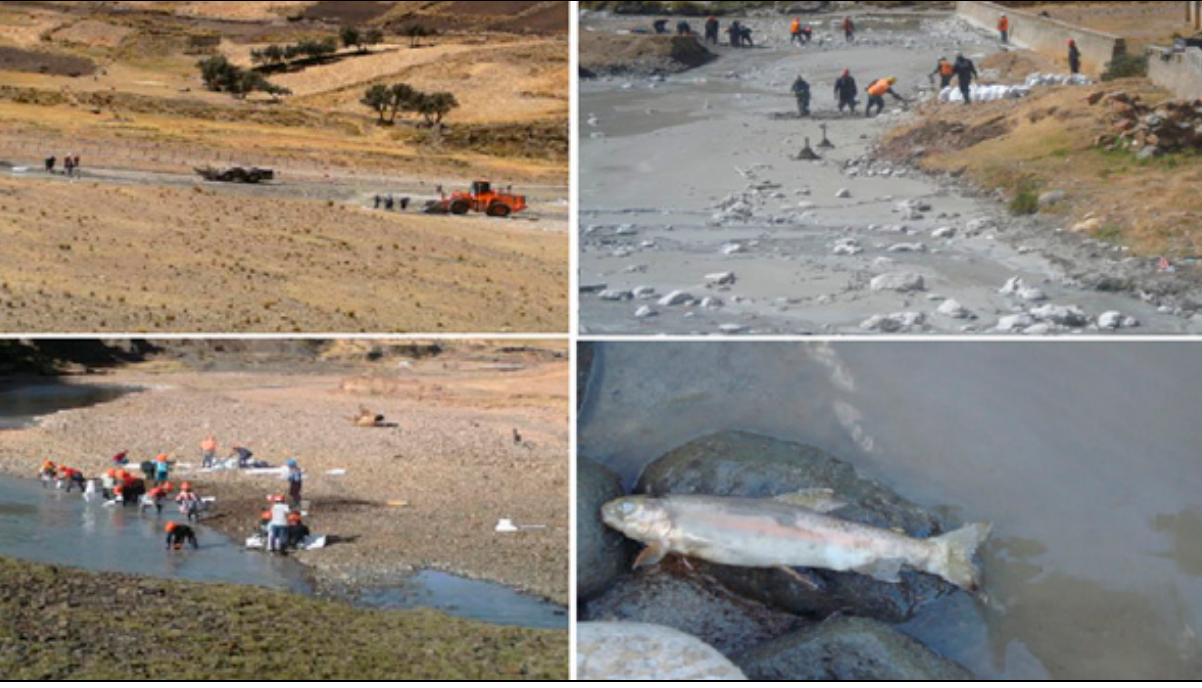
Figure 13. Impacts on agricultural-livestock activities, installation of fences for livestock [46].